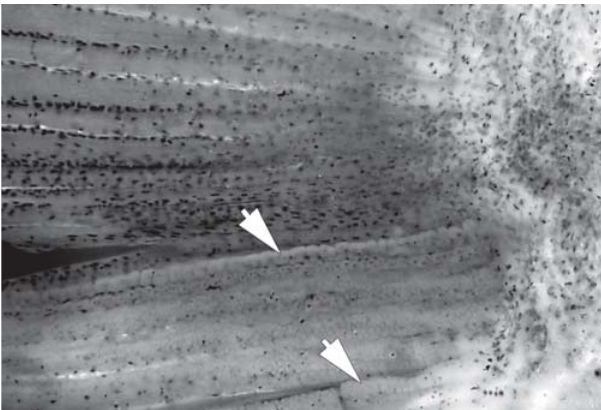
Fig. 5. Lophiobrycon weitzmani, paratype, adult male, MZUSP 83353, SL 26.5 mm SL; detail of caudal organ showing beaded glandular tissue indicated by arrows.